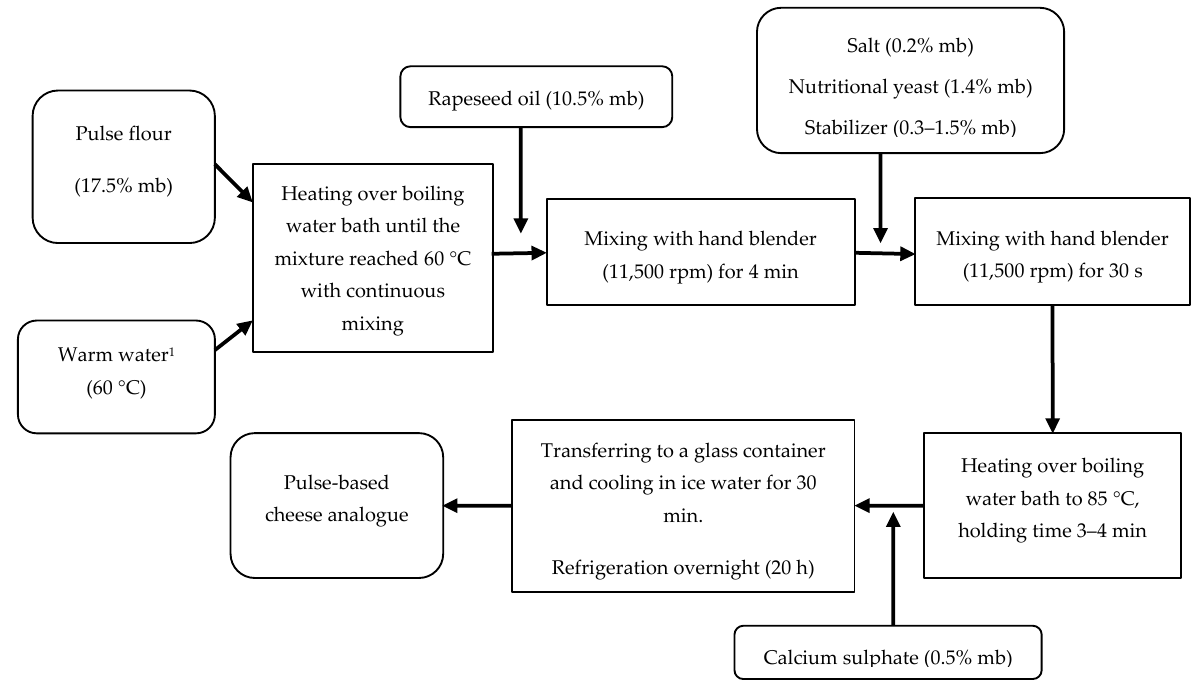
Figure 1. Pulse-based cheese analogue preparation according to Thresher [18]. 1 The amount of water was adjusted depending on the stabilizer amount in the formula. Note: mb = mass basis.